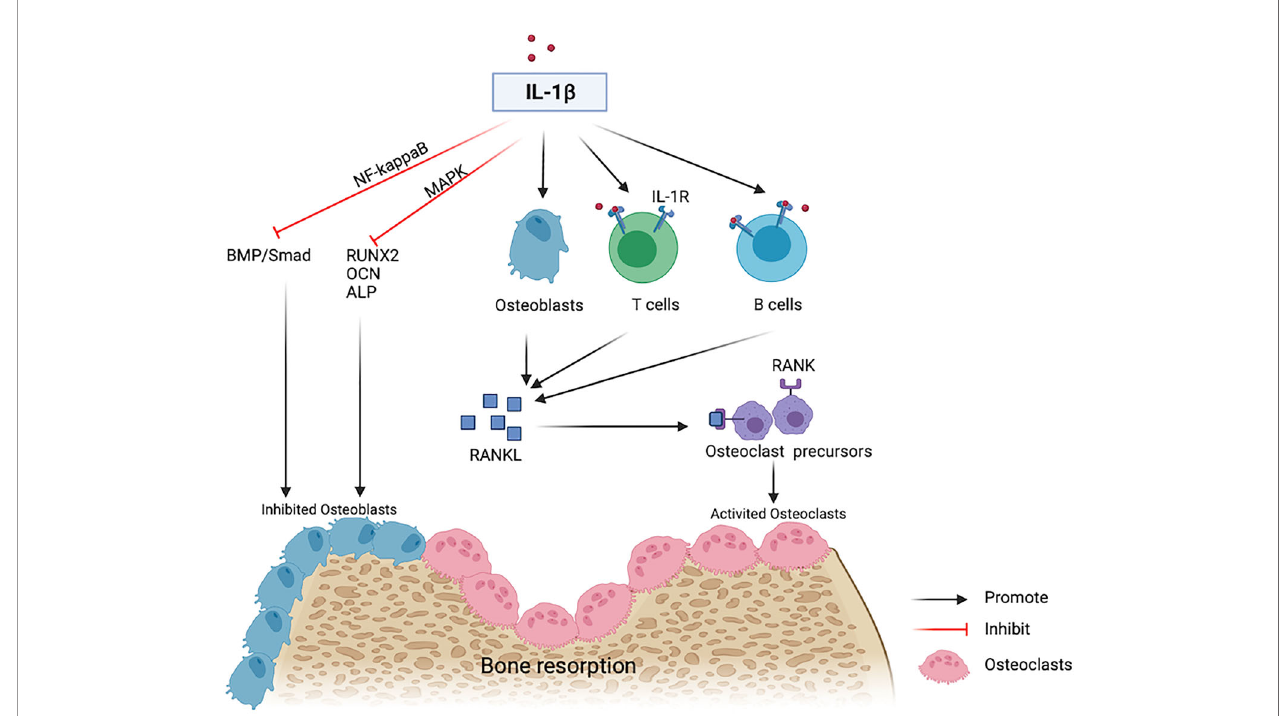
FIGURE 3 | IL-1beta contributes to bone resorption. IL-1 b inhibits osteogenic differentiation by inhibiting the BMP/Smad pathway and osteogenic markers including RUNX2, OCN and ALP. IL-1 b binds with IL-1R on T cells or B cells and induces the expression of RANKL on osteoblasts and then promotes activated osteoclasts via a RANKL-RANK independent